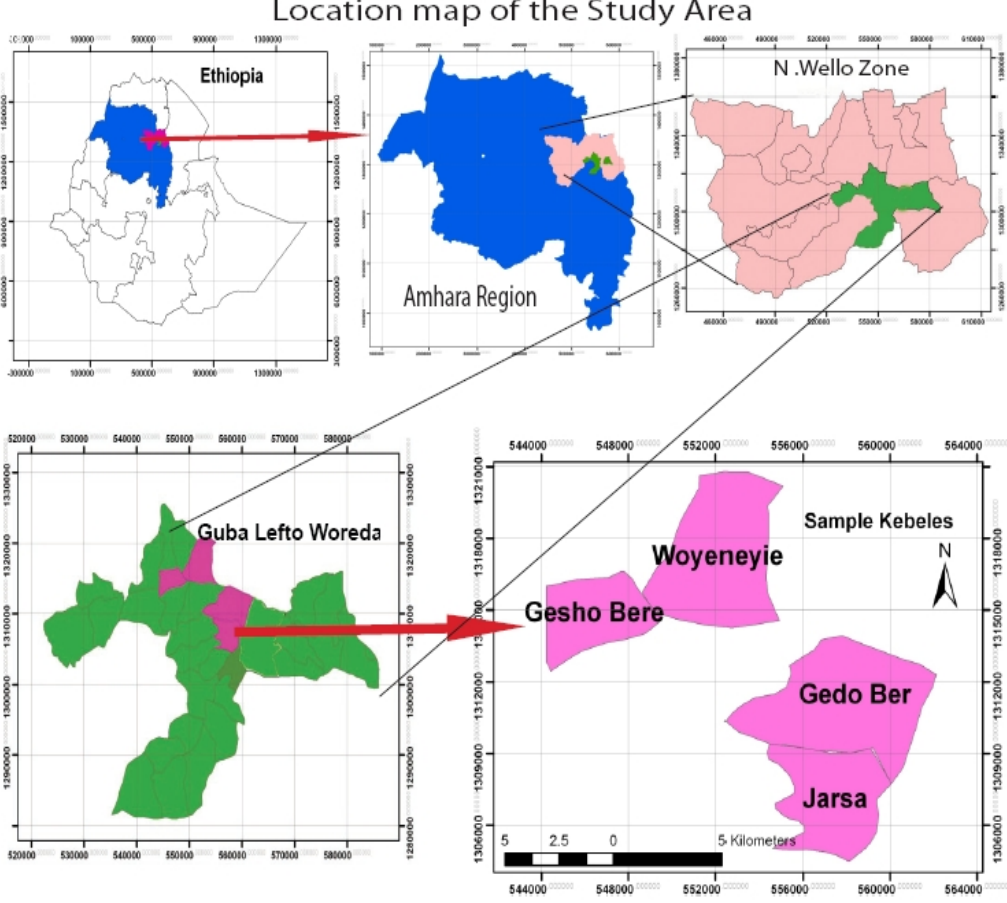
Figure 2. Location map of the study sites.